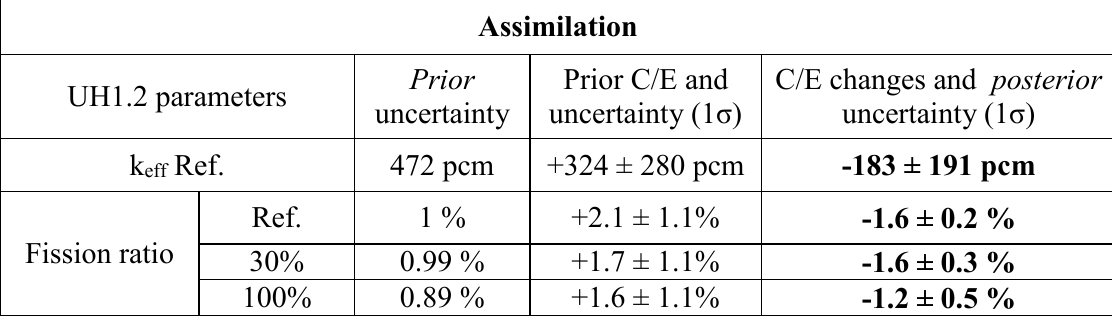
Table II. UH1.2 IDA results (k and fission ratio) : prior/posterior C/E and uncertainties (pcm). eff